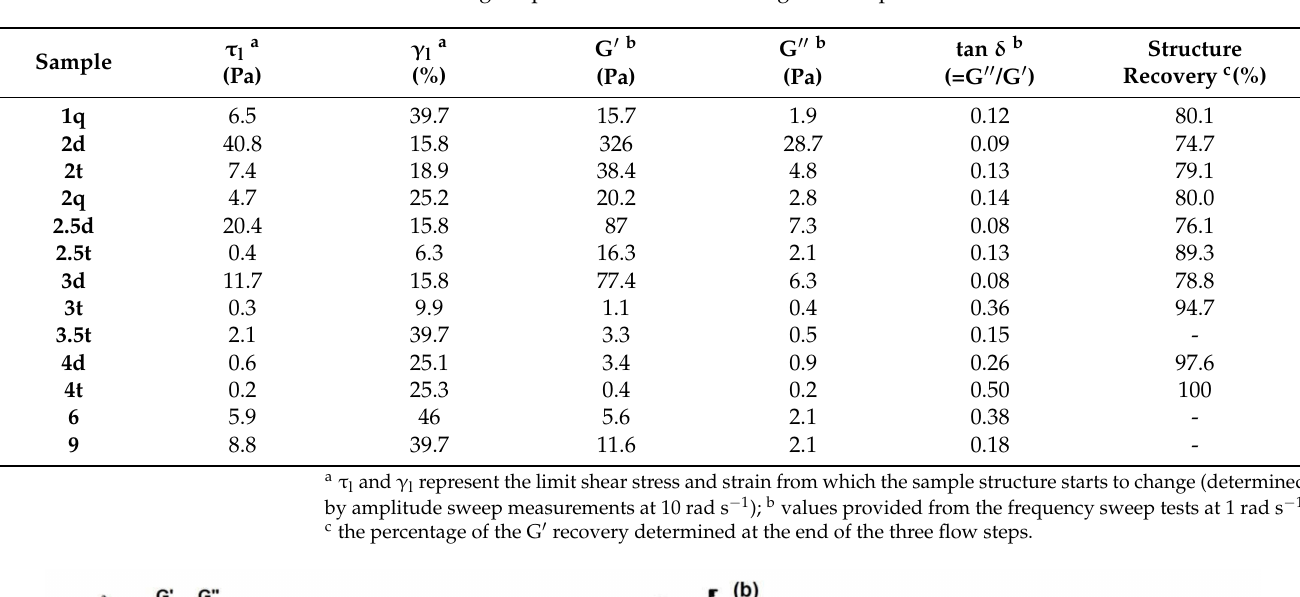
Table 2. Rheological parameters of the investigated samples.